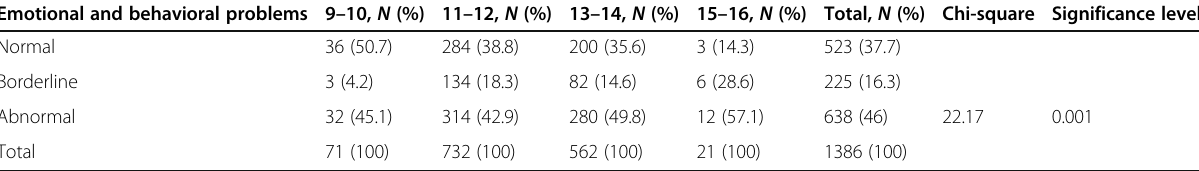
Table 4 The relationship between the age of menarche emotional and behavioral problems in the student city of Shiraz Emotional and behavioral problems 9 – 10, N (%) 11 – 12, N (%) 13 – 14, N (%) 15 – 16, N (%) Total, N (%) Chi-square Significance level